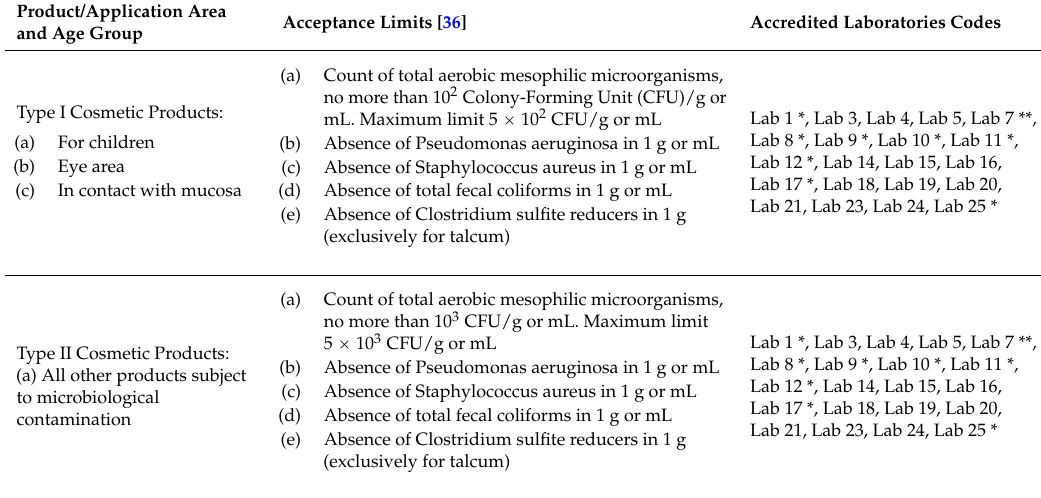
Table 8. Accredited laboratories for the evaluation of the microbiological parameters of